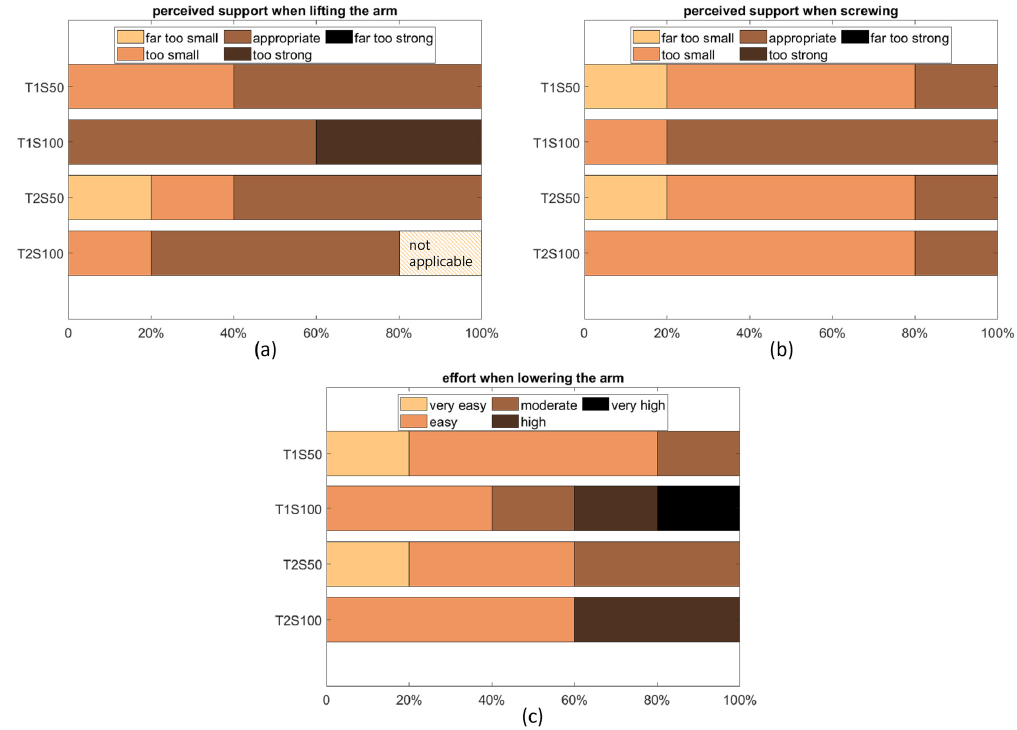
Figure 14. Subjective perception of ( a ) the support force when lifting the arm, ( b ) support when screwing-in, and ( c ) effort when lowering the arm. screwing-in, and ( c ) effort when lowering the